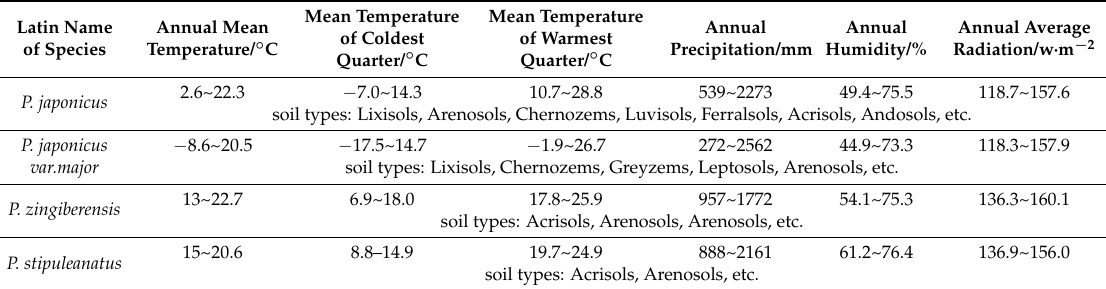
Figure 1. Global spatial distribution of sample points for four endangered Panax species, (blue) P. japonicas ; (red) P. japonicus var. major ; (yellow) P. zingiberensis ; (green) P. stipuleanatus . Table 2. The range of ecological factors for four endangered Panax species.